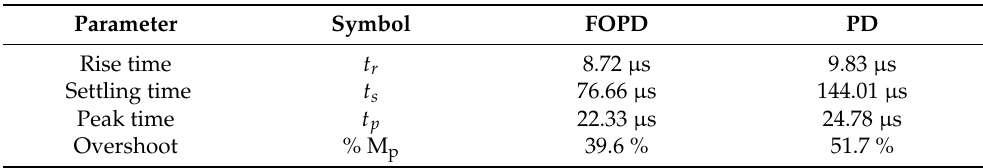
Table 7. Performance parameters for both step responses from Figures 7a and 12a, where FOPD is the fractional-order PD